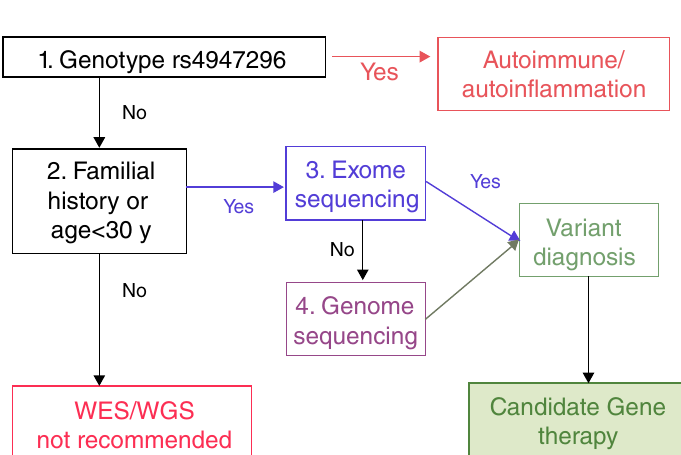
Figure 1. Potential algorithm for the genetic diagnosis of Ménière’s disease (MD). WES, whole exome sequencing; WGS, whole genome